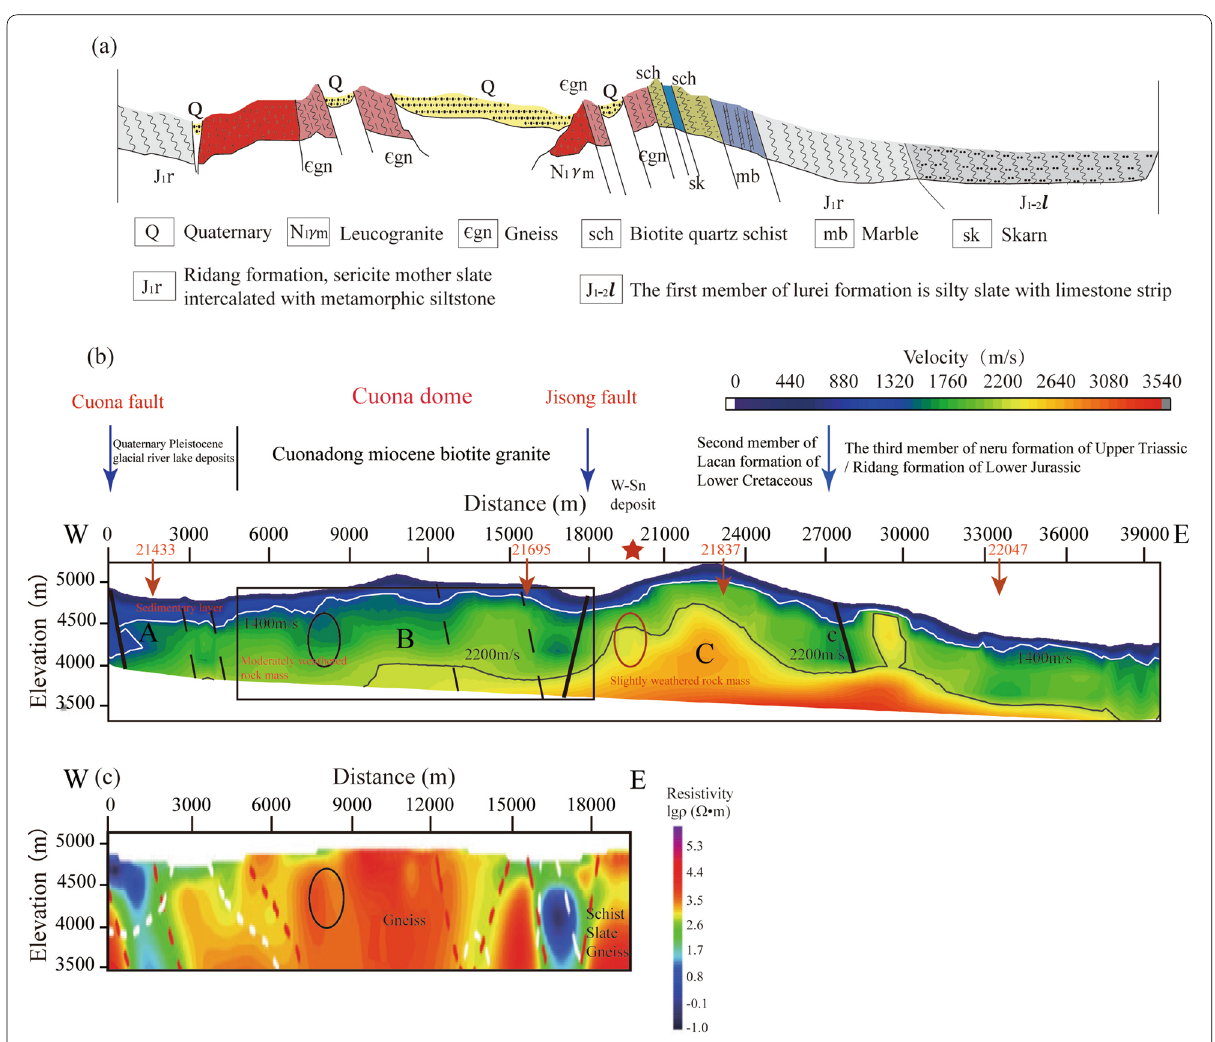
Fig. 9 Comprehensive interpretation of the S-wave velocity profile of the Cuonadong dome. a Geologic section. b S-wave velocity profile and c magnetotelluric profile modified according to Jiao et al.